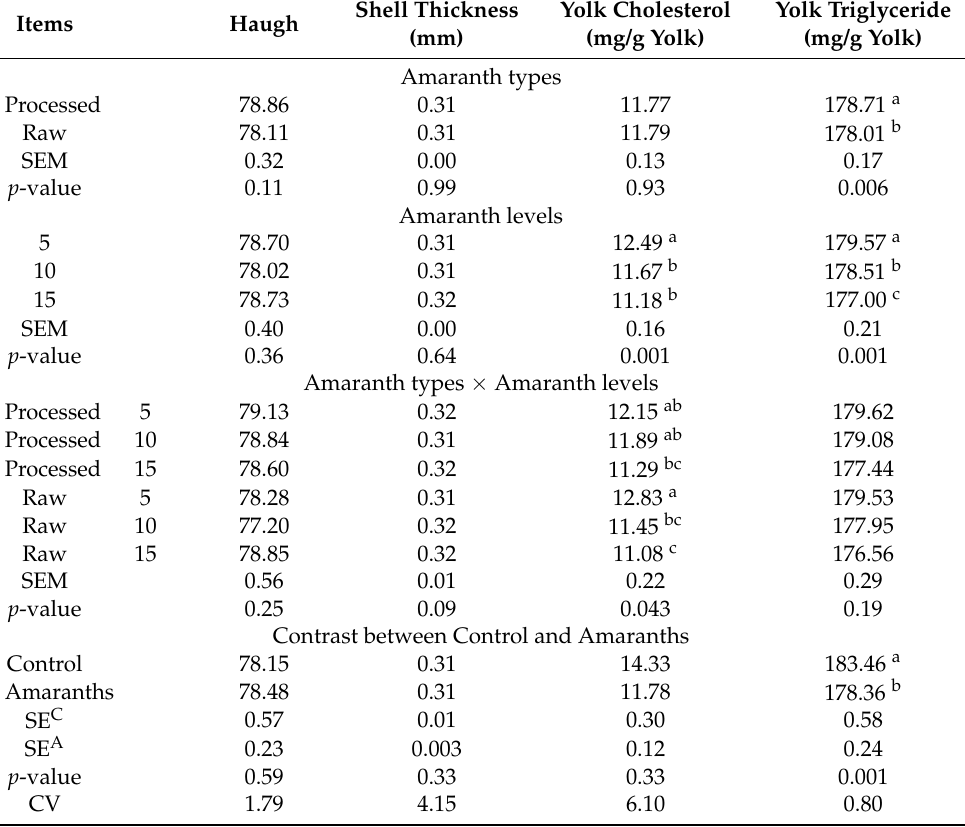
Table 4. Effect of trials diets on the egg physicochemical properties in laying